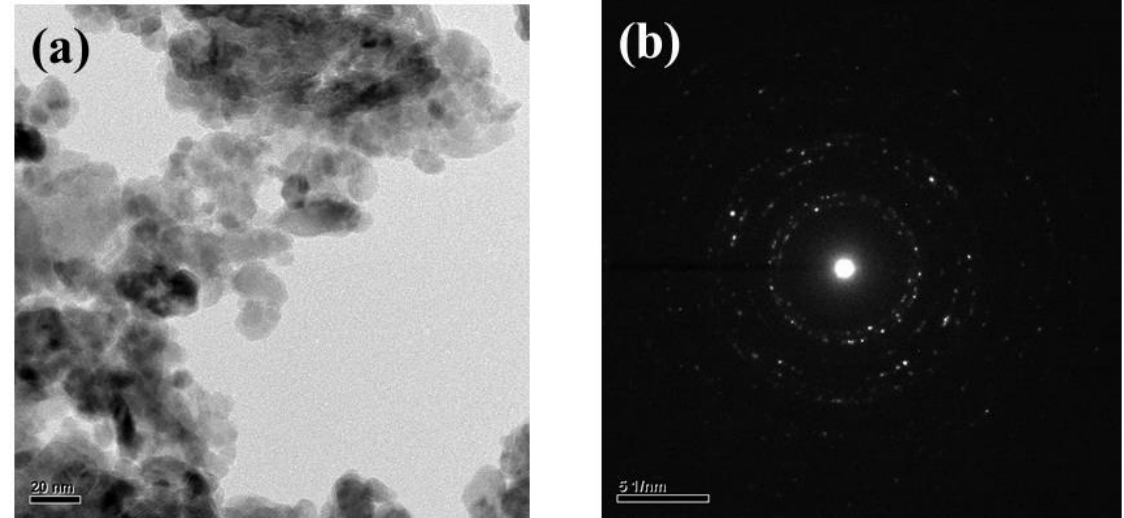
Figure 3. ( a ) The TEM image of the ZnO powder after ultrasonic grinding and ( b ) the selected area electron diffraction (SAED) image of the ZnO-NPs.